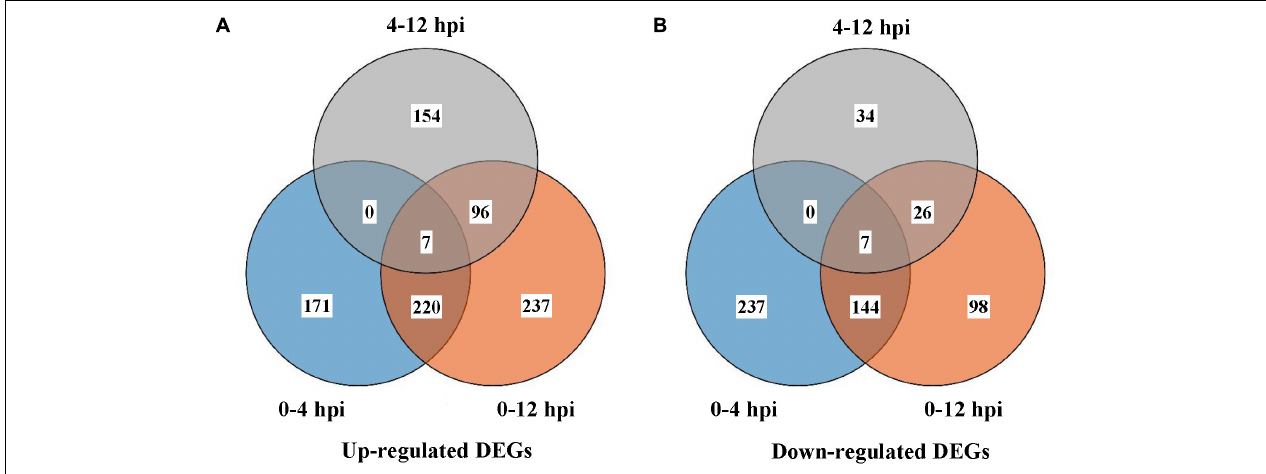
FIGURE 1 | Differentially expressed genes (DEGs) in S. sclerotiorum 0, 4, or 12 h after interacting with C. minitans . (A) Up-regulated DEGs of different comparison groups; (B) Down-regulated DEGs. Comparison groups were conducted between the different interaction time points. SsCm0h-vs-SsCm4h, SsCm0h-vs-SsCm12h and SsCm4h-vs-SsCm12h, the comparison groups of co-culture 4 h was versus to 0, 12 versus to 0 and 12 h compared to 4 h, respectively.